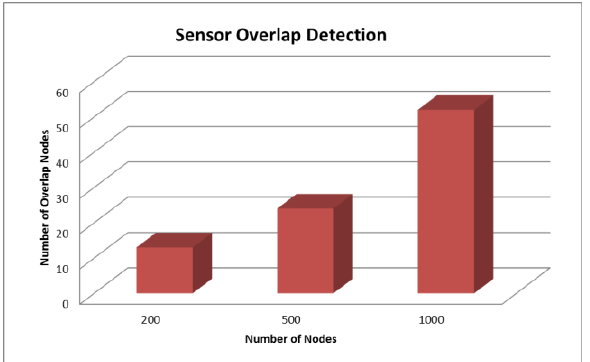
Figure 5. Number of L